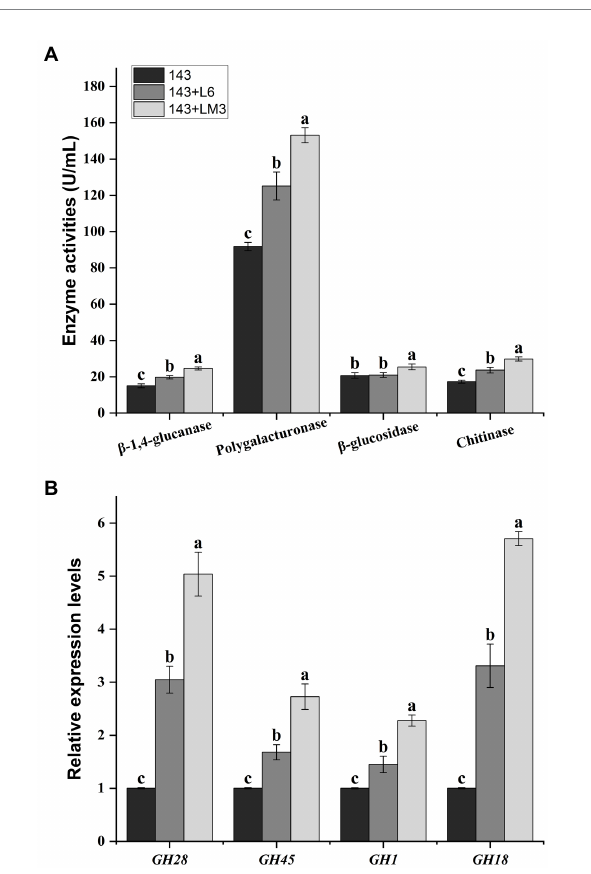
FIGURE 2 Effects of the fermented product of L6 or LM3 on the enzyme activities and gene expression of O. maius 143. (A) Effects of the fermented product of L6 or LM3 on the enzyme activities of O. maius 143. (B) Effects of L6 or LM3 on the expression of the mycorrhizal formation–related genes of O. maius 143. Treatments labeled with different letters are significantly different according to Tukey’s HSD at p < 0.05. Bars represent the standard deviations of the